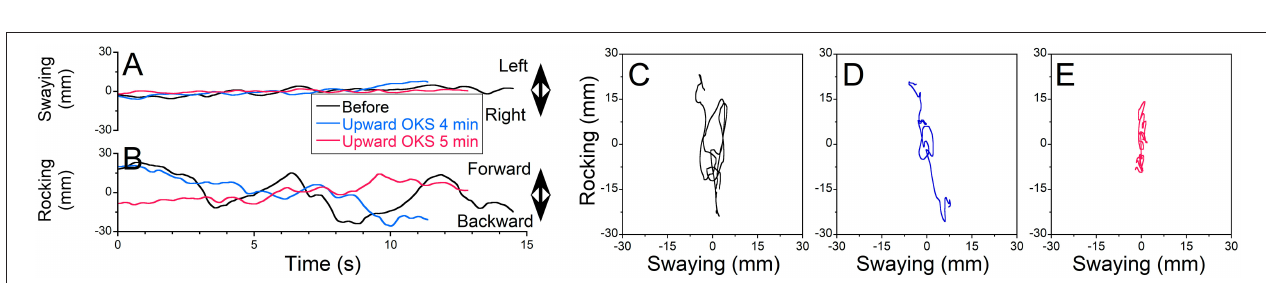
FIGURE 2 | The static post-urography obtained from patient VGR018 standing with feet apart and eyes closed over 15s. (A) Swaying. (B) Rocking (black trace, prior to treatment; blue, after treatment 1; red, after treatment 2). (C–E) X – Y plot of posture obtained prior to treatment (C) and after head motion side-to-side at 0.2Hz for 2min (D) and at 0.1Hz for 3min (E) .